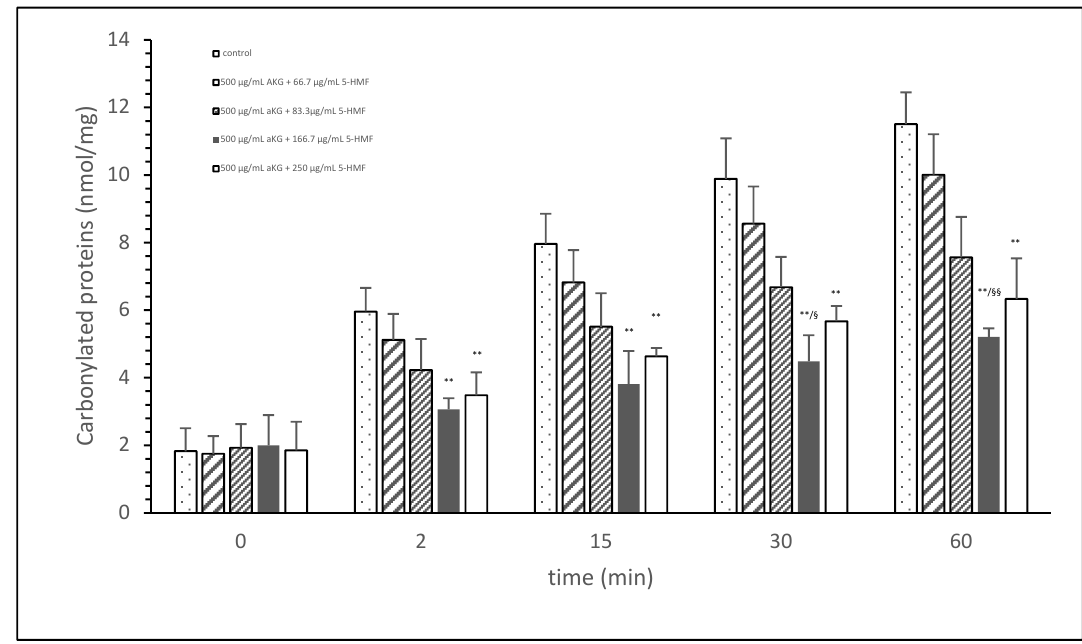
Figure 1. Cigarette smoke oxidatively modified proteins of FCS after cigarette smoke exposure in presence or absence of different AKG and 5-HMF combined solutions expressed with the content of carbonylated proteins ( n = 3). ** p < 0.01: significance between the control (0 µg/mL aKG + 0 µg/mL 5-HMF) and different combinations of aKG + 5-HMF after 2, 15, 30, and 60 min exposure. § p < 0.05: significance between the 500 µg/mL aKG + 83.3 µg/mL 5-HMF and 500 µg/mL aKG + 125 µg/mL 5-HMF. §§ p < 0.01: significance between the 500 µg/mL aKG + 83.3 µg/mL 5-HMF and 500 µg/mL aKG + 125 µg/mL 5-HMF.